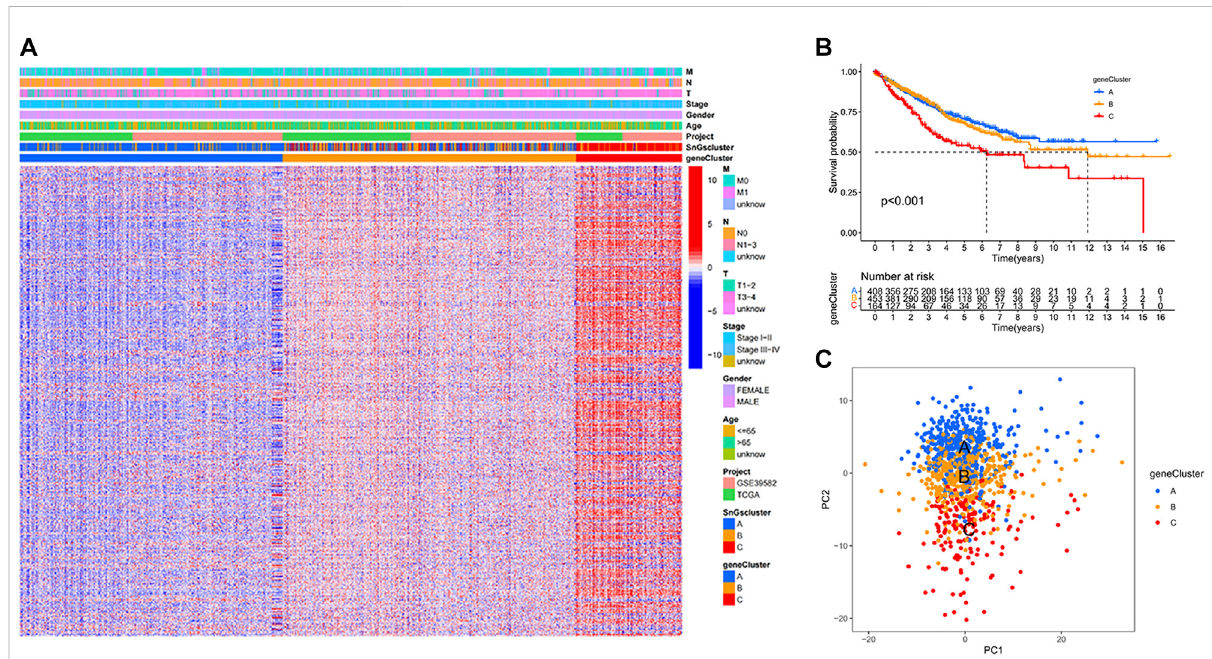
FIGURE 2 Three gene clusters based on prognostic differential gene expression levels. (A) Heat map. Prognostic differential genes were upregulated in gene Cluster C and down-regulated in gene Cluster A. (B) Kaplan-Meier survival curves. p < 0.001. (C) PCA plot. Blue dots represent patients in gene Cluster A; yellow dots represent patients in gene Cluster B; red dots represent patients in gene Cluster